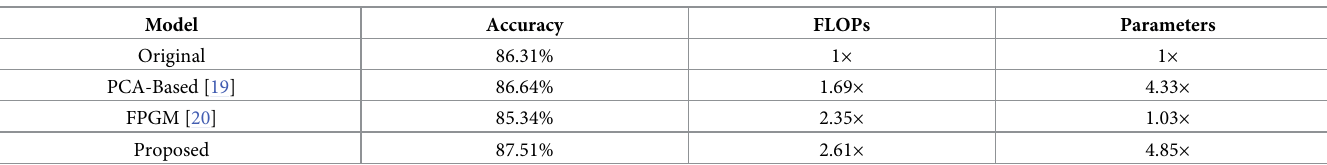
Table 6. Comparison of AlexNet on CIFAR-10.